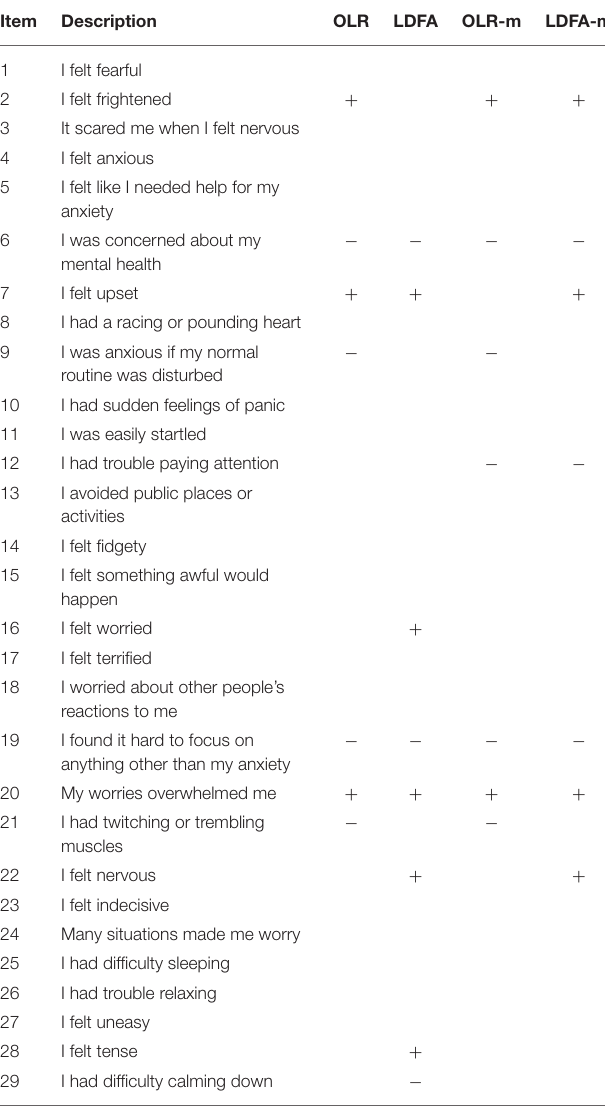
TABLE 3 | Results of the four DIF detection methods in the anxiety scale. Item